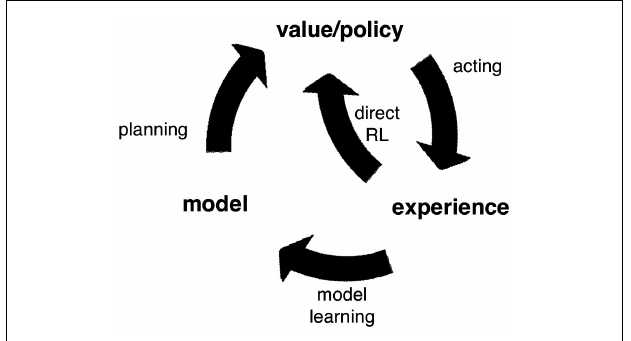
FIGURE 1 |The cycle of model revision over time (Sutton and Barto, 1998, p.